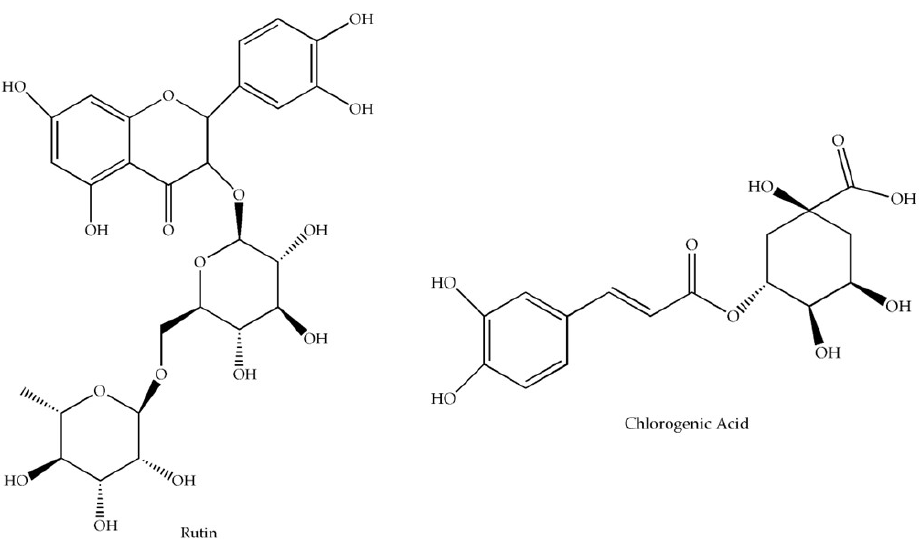
Figure 1. Chlorogenic acid and rutin chemical structures. The software ChemDraw 8.0 was used to draw the structures based on the PubChem chemistry database.